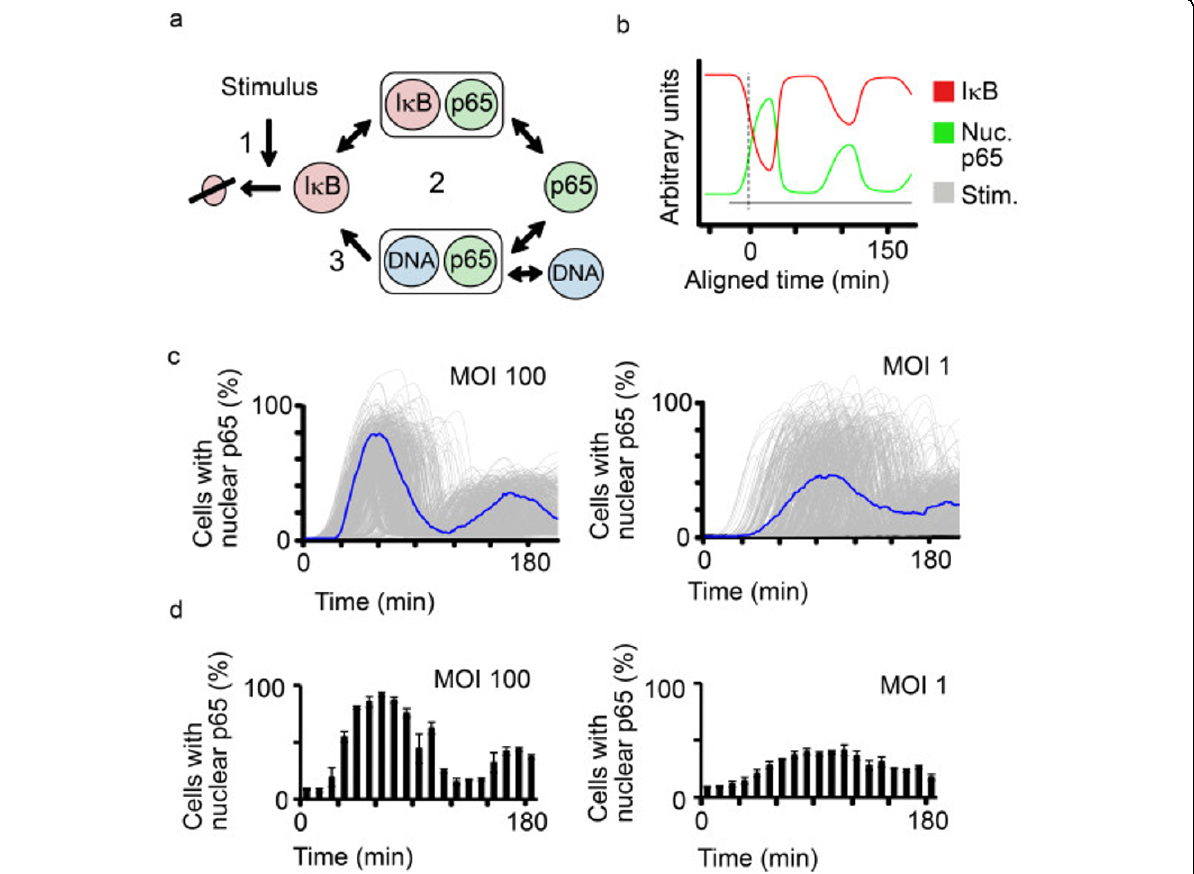
Figure 5 H. pylori -induced oscillations of p65 nuclear translocation at the population level are dependent on MOI in simulations and experiments . a) Mathematical model for simulating p65 oscillations: Stimulus induces degradation of I (cid:1) B a (1), I (cid:1) B a competitively inhibits binding of p65 to DNA (2) and transcription and translation is simplified by an activation delay (3). b) Mathematical model predicts oscillations of nuclear p65 (green) and protein levels of I (cid:1) B a (red) upon stimulation (grey) at the single-cell level. c) Simulation of population-level p65 oscillations after H. pylori infections at an MOI 100 and 1. Oscillations of p65 nuclear translocation within 500 individual cells were simulated (grey lines) and percentages of cells with nuclear p65 (blue line) were determined by a threshold set for nuclear p65. d) Experimental confirmation of predicted population-level oscillations of p65 (at MOI 100 and 1). AGS SIB02 cells were infected with H. pylori at the indicated MOI, fixed, analyzed by automated microscopy and then the percentage of cells with nuclear p65-GFP was determined, as described in Figure 2. Error bars = SD of experiment performed in triplicates. Results are representative of three independent